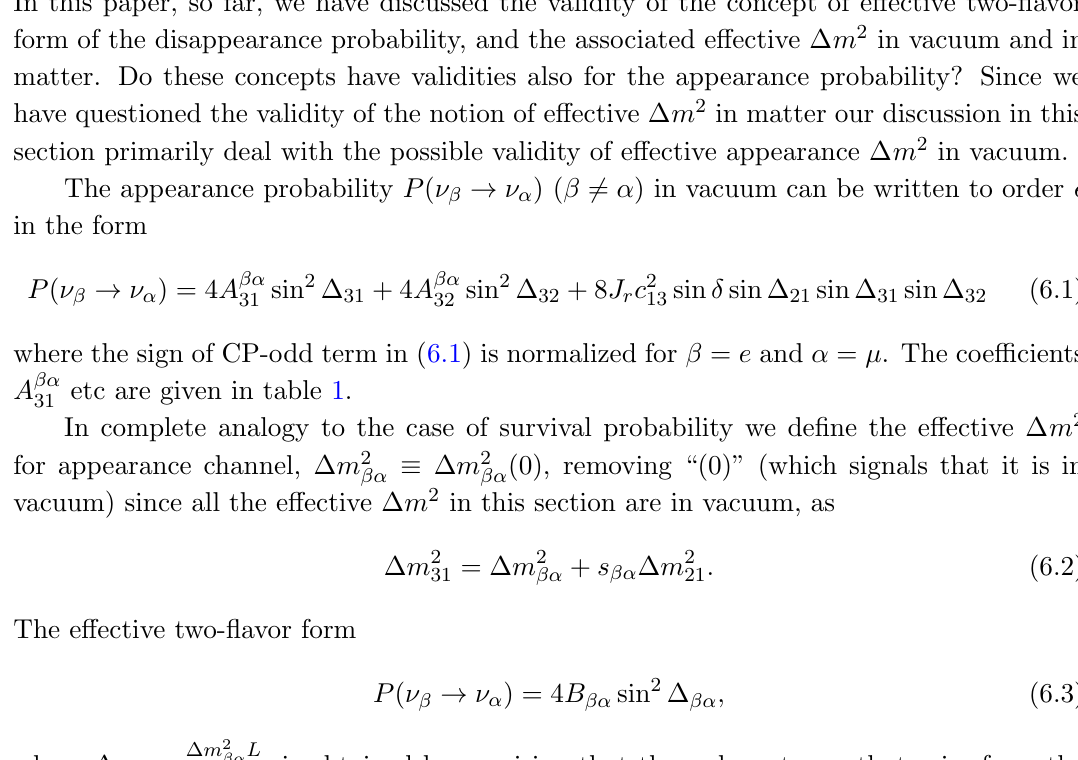
6 E(cid:11)ective two-(cid:13)avor approximation of appearance probability in